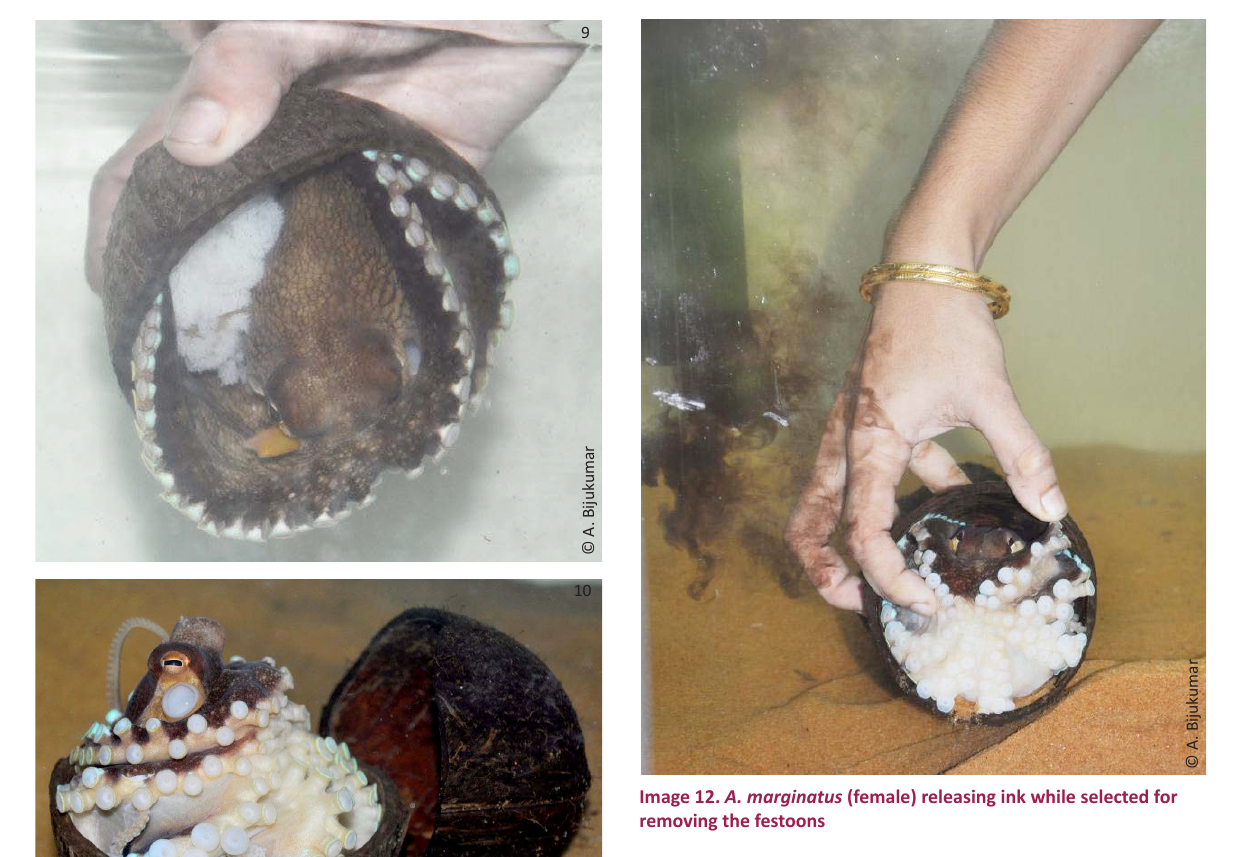
was held close to the body on the aboral side. The female became more active and vigilant during brooding and took extreme care to remove anything that came near the spawn. The octopus squatted directly over